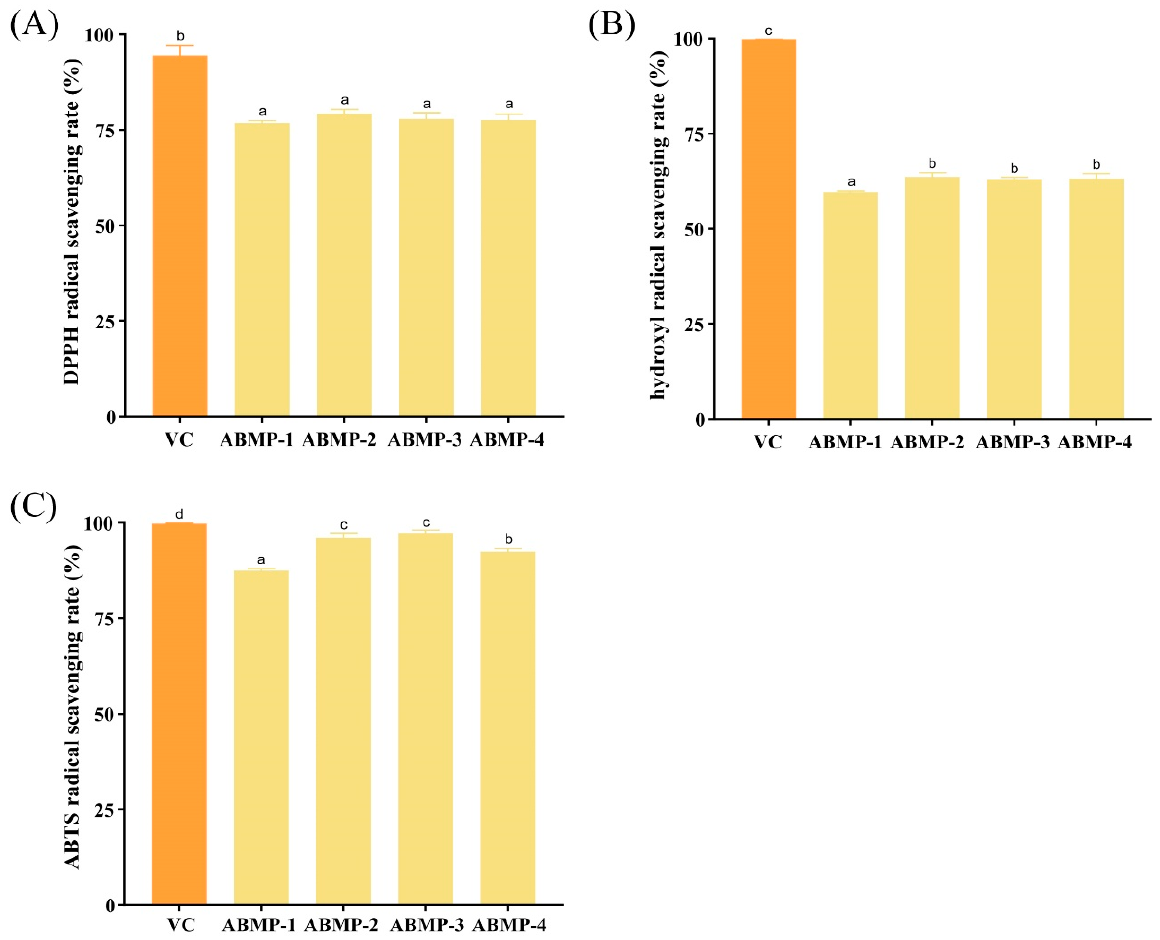
Figure 3. Antioxidant capacity of different fractions of ABMP. ( A ) DPPH radical scavenging rate; ( B ) Hydroxyl; ( C ) ABTS radical scavenging rate. Results were expressed as means ± SD (n = 3). Statistical significance analysis between different groups was done by the Tukey HSD test. Values marked with different letters (a, b, c, and d) were significantly different ( p < 0.05). VC was a positive control group.